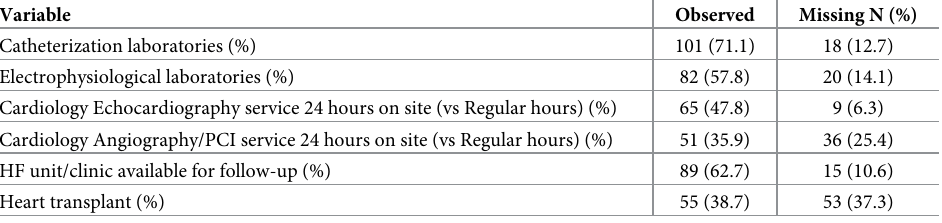
Table 2. Hospitals’ baseline characteristics.